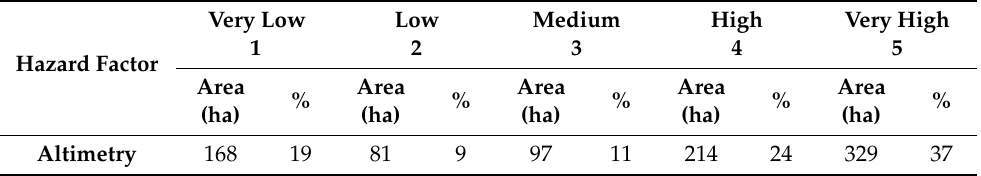
Table 20. Areas and percentages of the study area classified as each class of the altimetry hazard factor.